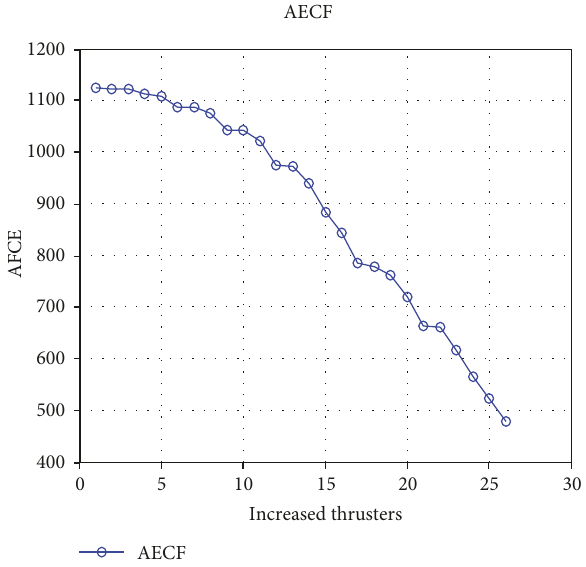
Figure 4: Relationship between optimization thruster and